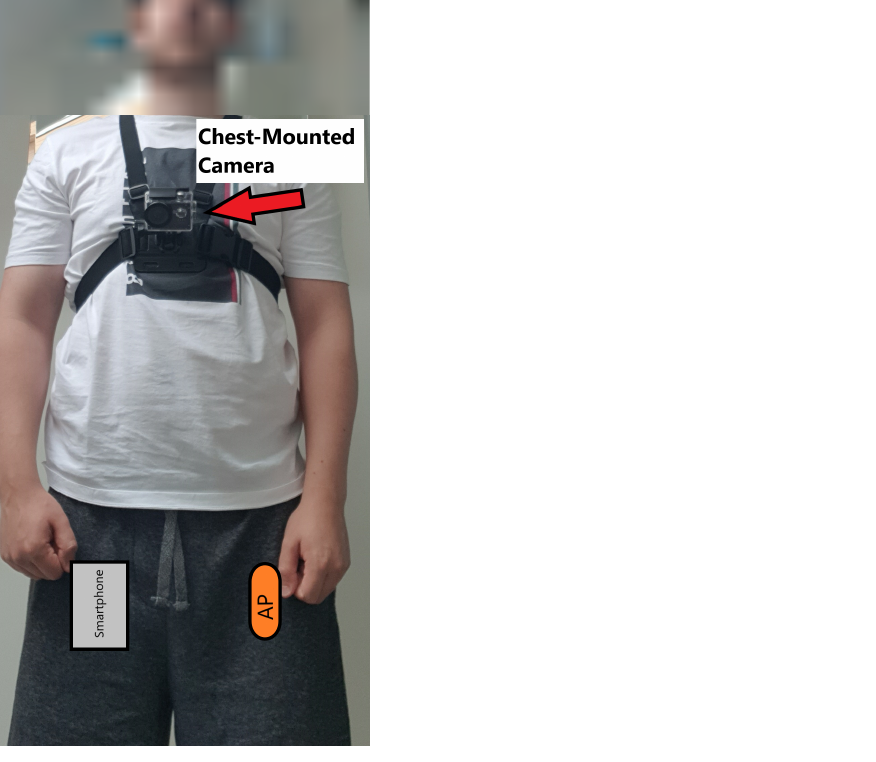
Figure 2. Example of a recording set-up. AP = ActivPAL. The smartphone and ActivPAL would both be worn under